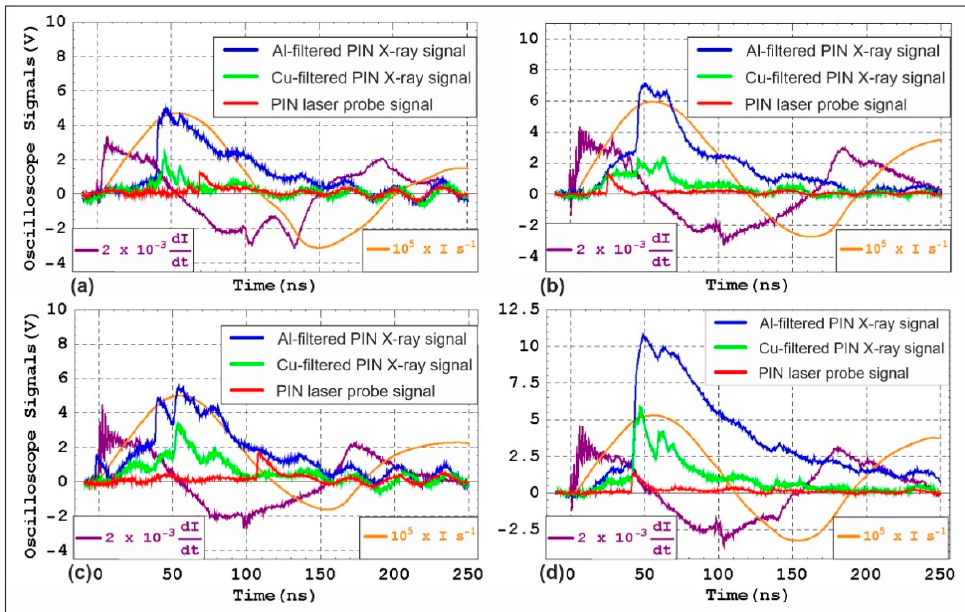
Figure 3. Typical electrical signals as recorded on the oscilloscope for the X-pinch loads: ( a ) W wires crossed at 98°, ( b ) W wires crossed at 55°, ( c ) Au-plated W wires crossed at 98°, and ( d ) Au-plated W wires crossed at 55°. The dI/dt and I waveforms are plotted in purple- and brown-colored lines, respectively.